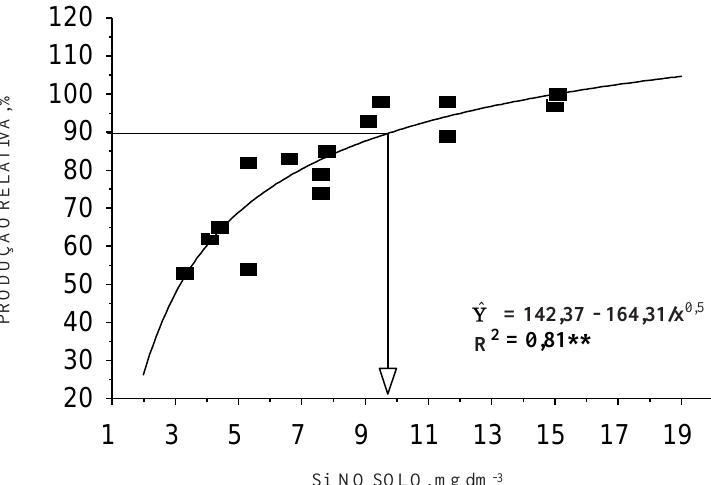
Figura 2. Relação entre a produção relativa e o teor de Si “disponível” no solo extraído com ácido acético 0,5 mol L -1 (solo LRd